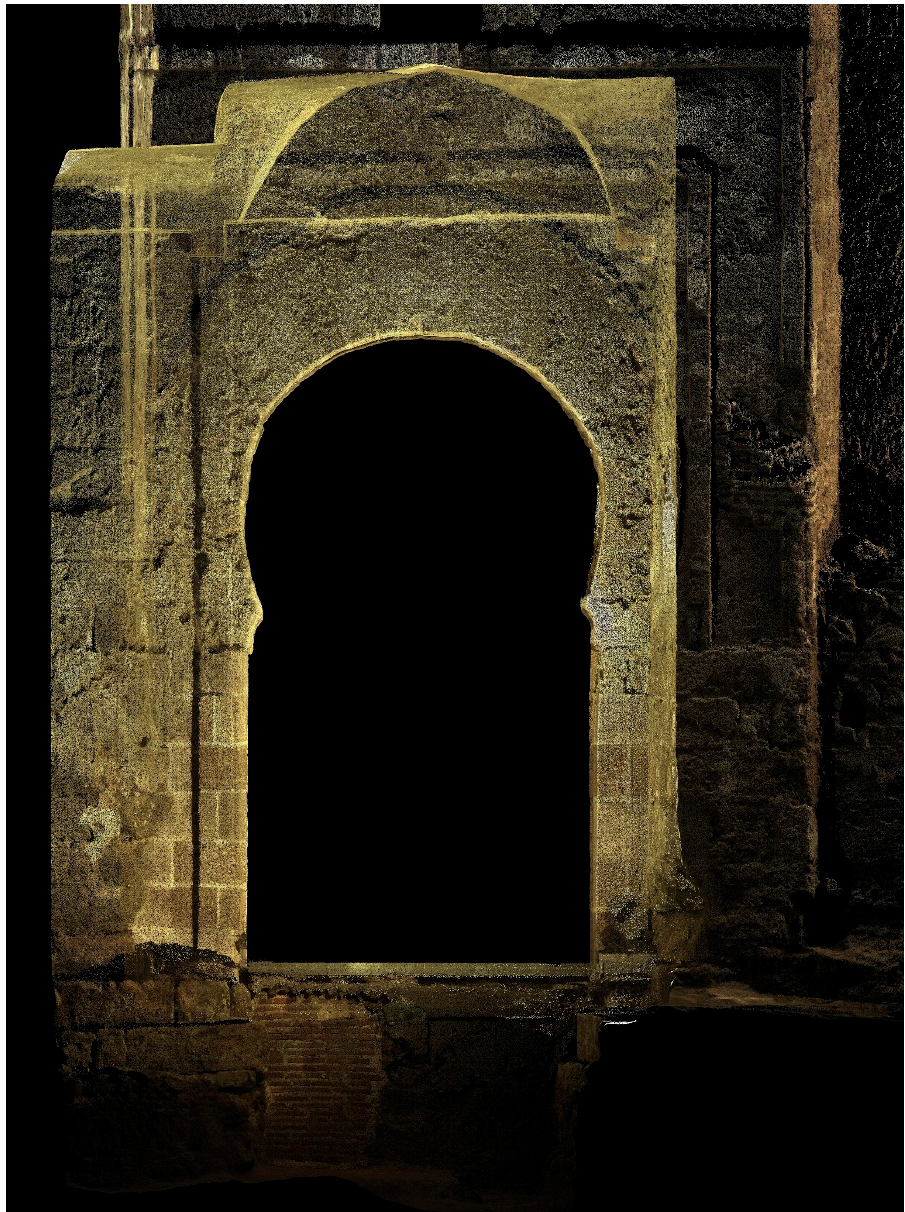
Figure 6. Orthoimage obtained from the point-cloud.